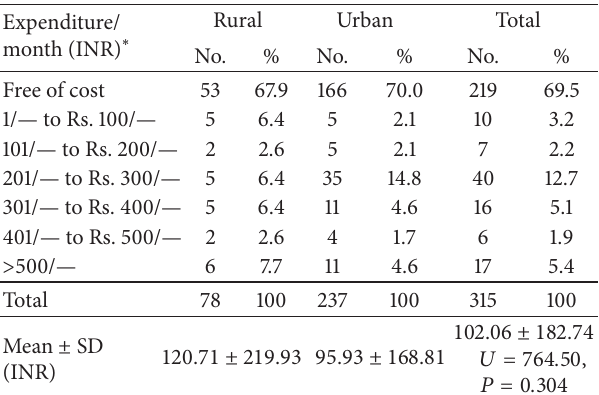
Table 2: Distribution of the study population according to the average drug expenditure ( 𝑛 = 315 ).